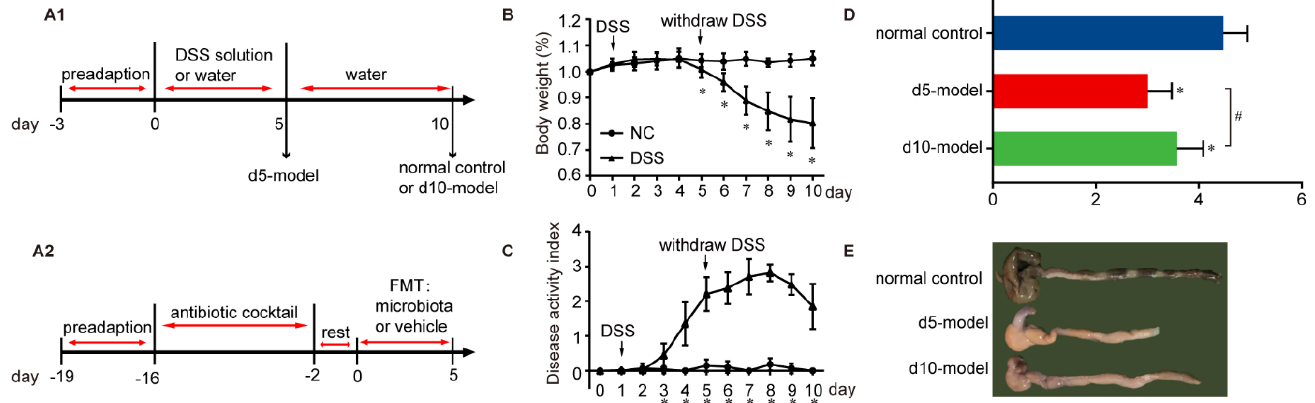
Figure 1. Clinical signs of IBD mouse model. ( A1 ) Experimental design of time-dependent microbial changes in colitis. ( A2 ) Experimental design of microbiota transplantation. ( B ) Body weight changes (relative to original weight, set as 100%) and ( C ) DAI over the whole experimental period. NC, n = 9; DSS, D 0 to d 5, n = 18; d 6 to d 10, n = 9. Differences were determined via a two-way ANOVA followed by a Sidak ’ s multiple comparisons test. ( D ) Length of the colon between the ileocecal junction and the proximal rectum, n = 9. Data were analyzed by one-way ANOVA, followed by Tukey ’ s multiple comparisons test, n = 9. ( E ) The representative pictures of colon. All of the data are expressed as the mean ± SD. * p < 0.05 compared with the normal control group; # p < 0.05 compared with the d 5 model group and the same below.